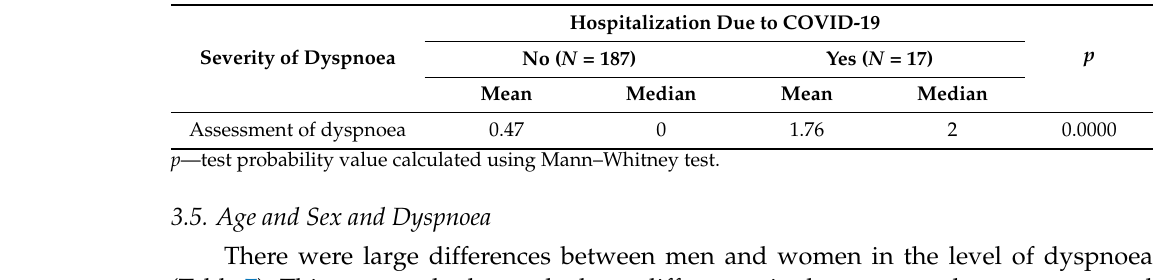
Table 6. Hospitalization for COVID-19 and dyspnoea.